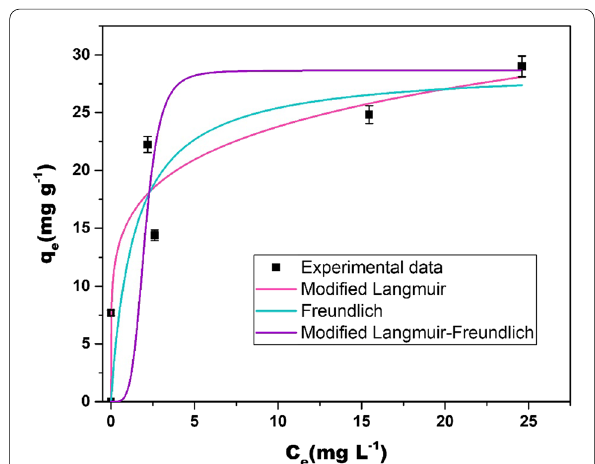
Fig. 7 Plot of equilibrium adsorption capacity ( q e ) versus residual Cr(VI) in C G beads system ( C e ) for different adsorption +